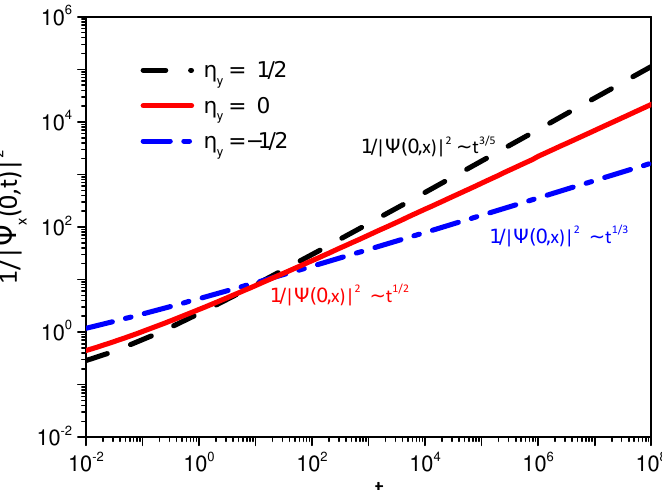
Figure 6. This figure illustrates the behavior of 1/ | Ψ x ( 0, t ) | 2 for different values of η y . We consider, for simplicity, ¯ hl / ( 2 m ) = 1, l = 1 and the initial condition ϕ x ( x ) = e − x 2 / ( 2 σ 2 ) / (